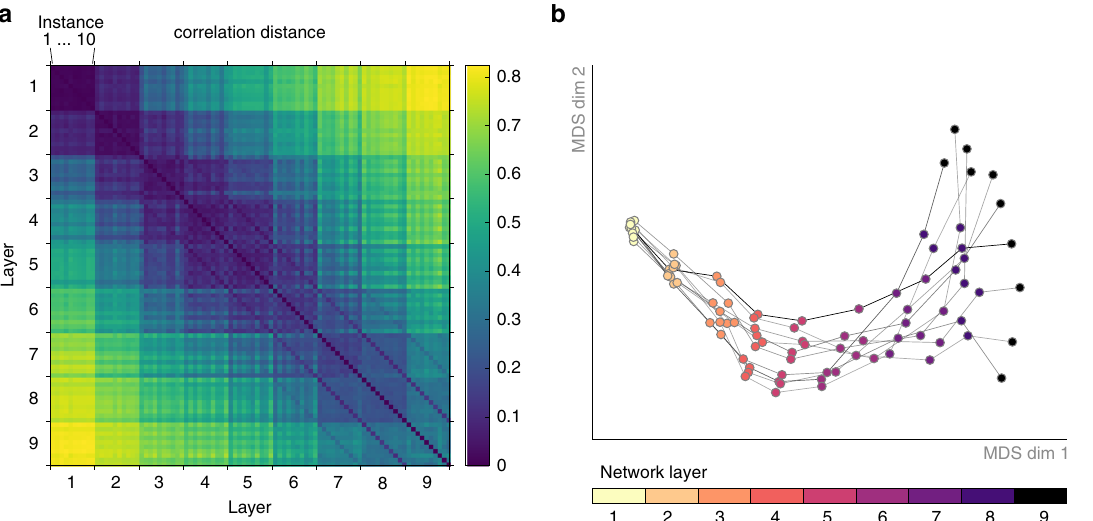
Fig. 3 Network individual differences emerge with increasing network depth. a We compare the representational geometries across all network instances (10) and layers (9 convolutional) for All-CNN-C by computing all pairwise distances between the corresponding RDMs. b We projected the data points in a (one for each layer and instance) into 2D via MDS. Layers of individual network instances are connected via gray lines. While early representational geometries are highly similar, individual differences emerge gradually with increasing network depth.